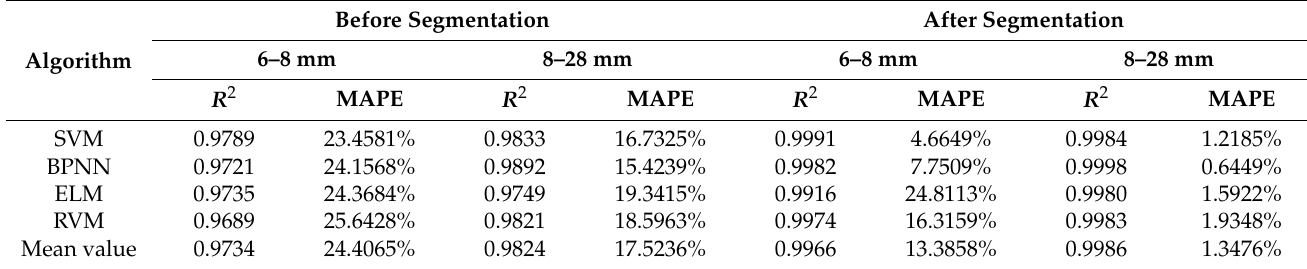
Table 8. Prediction performance before and after the data